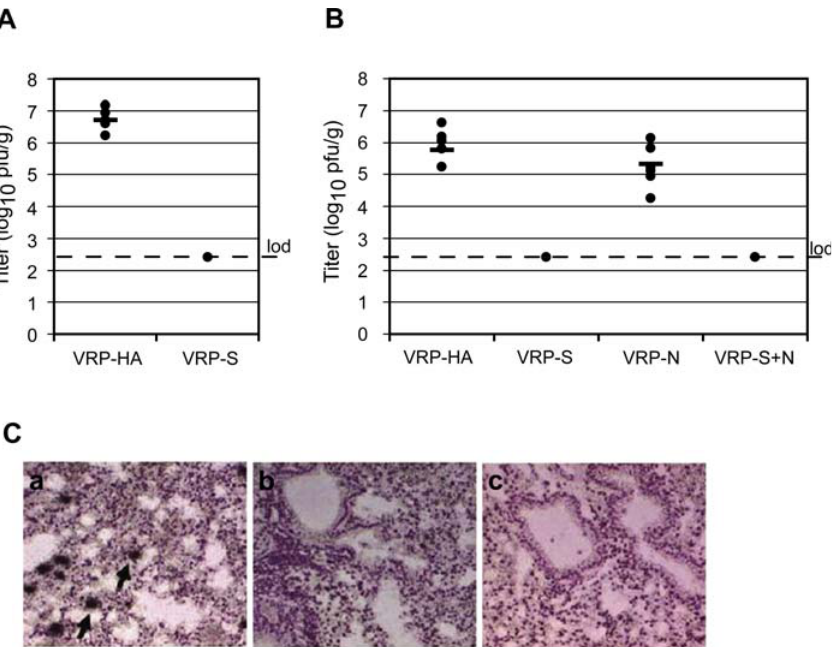
Figure 2. VRP-S Induces Short- and Long-Term Protection against icSARS-CoV Challenge icSARS titers are expressed as the log 10 plaque-forming units per gram (pfu/g) of lung. Tissues were homogenized in PBS to form a 20% suspension and titered on Vero monolayers. The titers for individual mice are shown as a filled circle, and the mean titer for the group is represented by a solid bar. Limit of detection (lod) is 2.4 log 10 pfu/g. (A) Lung titers of16-wk-old BALB/c mice harvested 2 d after being i.n. infected with 10 5 PFU of icSARS-CoV ( n ¼ 6). (B) Lung titers of BALB/c mice vaccinated and boosted with 10 6 infectious units (IU) of VRP expressing the influenza HA (VRP-HA), SARS-S glycoprotein (VRP-S), SARS-N protein (VRP-N), or a combination of VRP-S and VRP-N (VRP-S þ N). Mice ( n ¼ 7 VRP-HA, n ¼ 8 for other groups) were vaccinated at 5 wk of age, boosted 5 wk later, then i.n. challenged with 10 5 pfu of icSARS-CoV 54-wk post-boost. Lungs were harvested 4 d later and titered. (C) Plaque assay results were confirmed by in situ hybridization to sectioned lungs of five mice from each vaccinated group with a radiolabeled riboprobe complementary to the SARS CoV N gene. In senescent mice challenged with the icSARS-CoV, representative lung sections from VRP-HA– (unpublished data) and VRP-N–vaccinated (a) animals exhibited extensive in situ signal (black arrows), whereas only one of five sections from